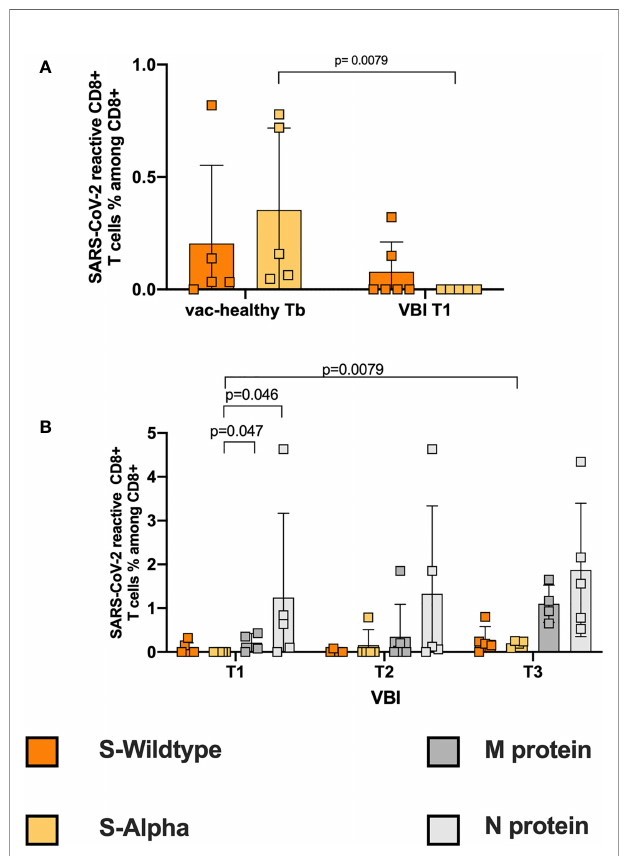
FIGURE 2 | Failure to induce a strong SARS-CoV-2 reactive cytotoxic CD8+ response. (A) Correlation of S-WT and S-Alpha reactive CD8+ T cells between controls at Tb and VBI patients at T1. In the VBI cohort there is an absence of S-Alpha reactive CD8+ T cells at disease onset, accompanied by decreased frequencies of S-WT reactive CD4+ T cells, compared to the control. (B) Correlation of S-WT, S-Alpha, M- and N-reactive CD8+ T cells among VBI. There are statistically signi fi cant higher frequencies of M- and N- reactive T cells compared to S-Alpha reactive T cells on disease